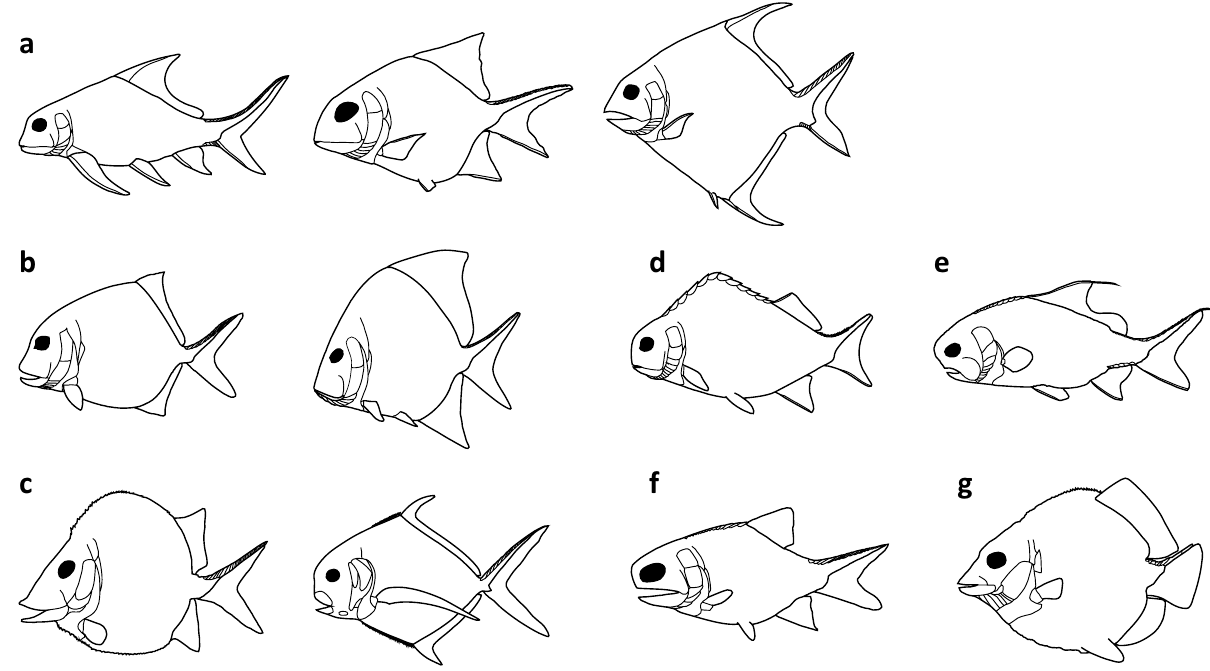
Figure 1. Diversity of body shapes among possible independent origins of deep-bodied actinopterygians listed by Sallan and Coates 9 . Lines on the leading margin of fins indicate fringing fulcra. ( a ) Eurynotiformes. From left to right: Eurynotus , modified from Sallan and Coates 9 , Fig. 15 and Traquair 10 , Plate III, Fig. 1; Cheirodopsis , modified from Sallan and Coates 9 , Fig. 15 and Moy-Thomas and Dyne 11 , Fig. 36; and Amphicentrum , modified from Sallan and Coates 9 , Fig. 15. ( b ) ‘Lower’ platysomids. From left to right: Platysomus striatus , modified from Haubold and Schaumberg 12 , Fig. 104; and Platysomus superbus , modified from Moy-Thomas and Dyne 11 , Fig. 39. ( c ) Bobasatraniiformes. From left to right: Platysomus schultzei , drawn from Zidek 13 , Figs. 22 and 24; and Bobasatrania , modified from Schaeffer and Mangus 14 , Fig. 11. ( d ) Adroichthys , modified from Gardiner 15 , Fig. 15. ( e ) Aesopichthys , modified from Poplin and Lund 16 , Fig. 12. ( f ) Frederichthys , modified from Coates 17 , Fig. 8. ( g ) Discoserra , drawn from Lund 18 , Figs. 5, 7,